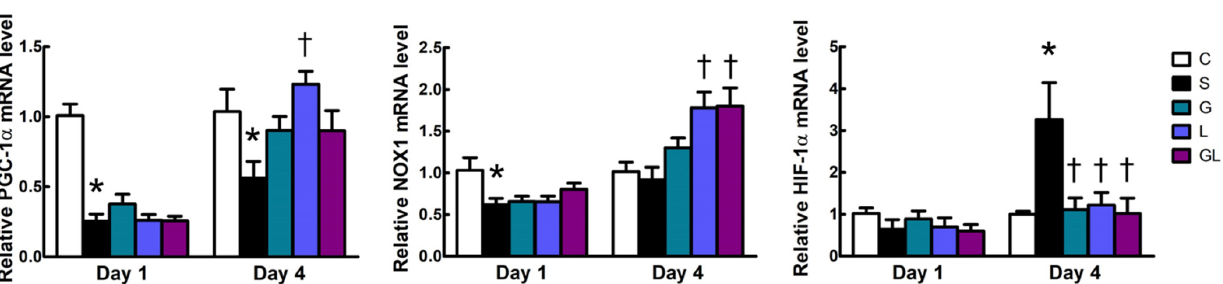
Figure 5. Muscle mRNA expressions of mitochondrion-related genes. The groups are described in the legend to Table 1, and gene abbreviations are given in the footnotes to Table 2. Student’s t -test was used to analyze differences between the C and S groups at the same time point. Differences among septic groups on the same day were analyzed by a one-way ANOVA with Tukey’s post-hoc test. * Significantly differs from the C group. † Significantly differs from the S group ( p < 0.05).